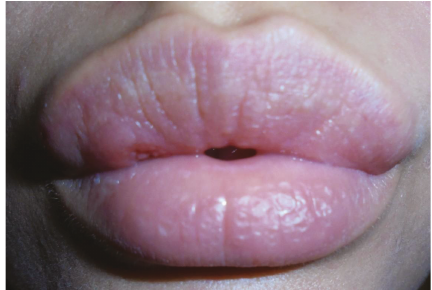
Figure 3: Anterior view of patient at follow-up, one week post- management.